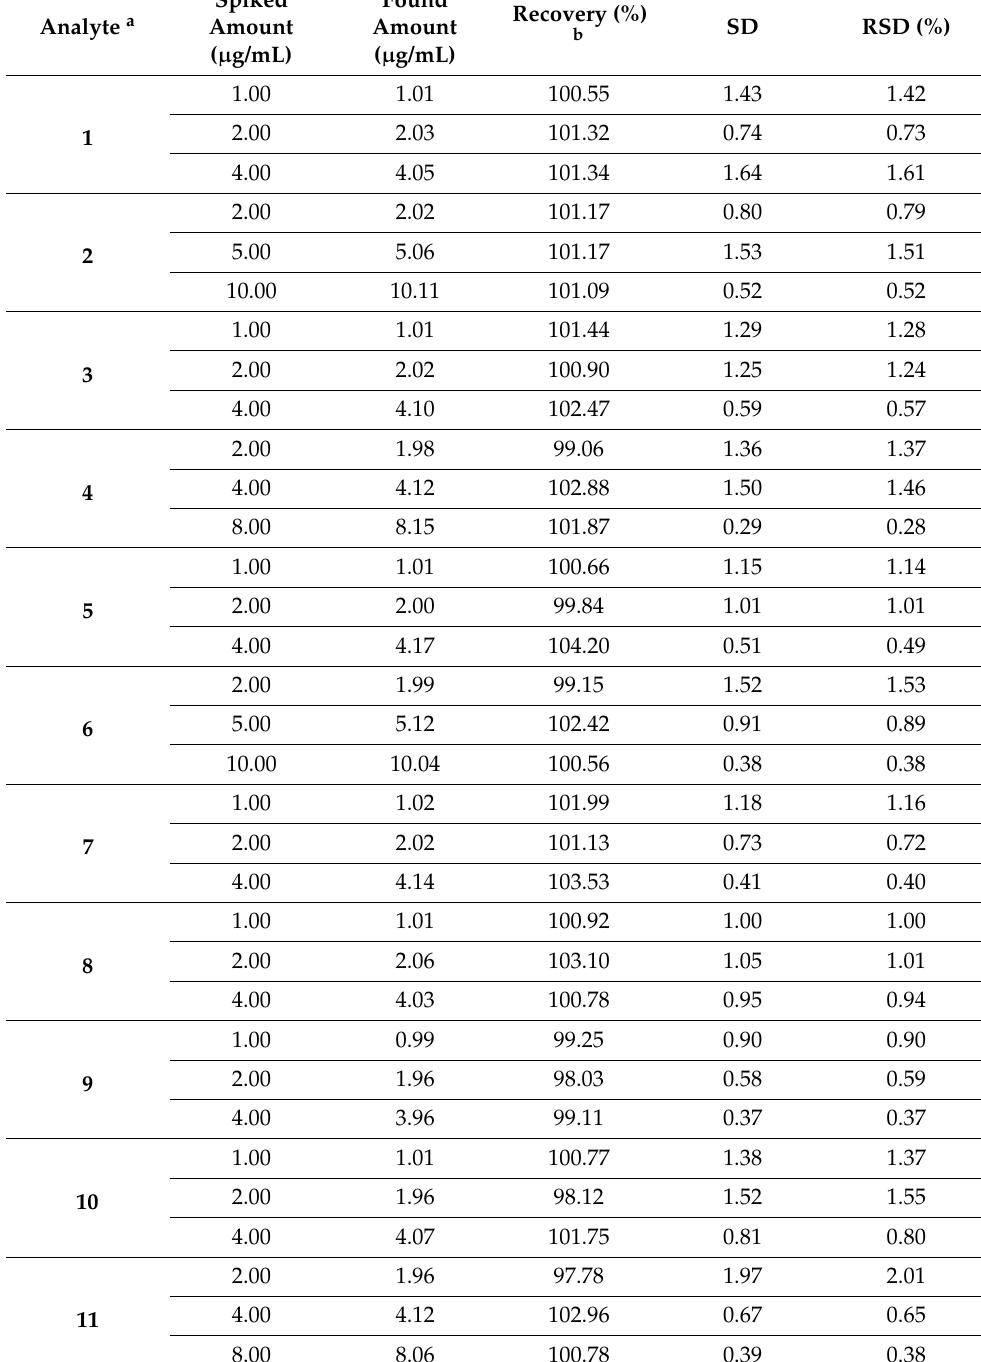
Table 3. Extract recovery (%) for a simultaneous determination of 11 analytes in the developed HPLC